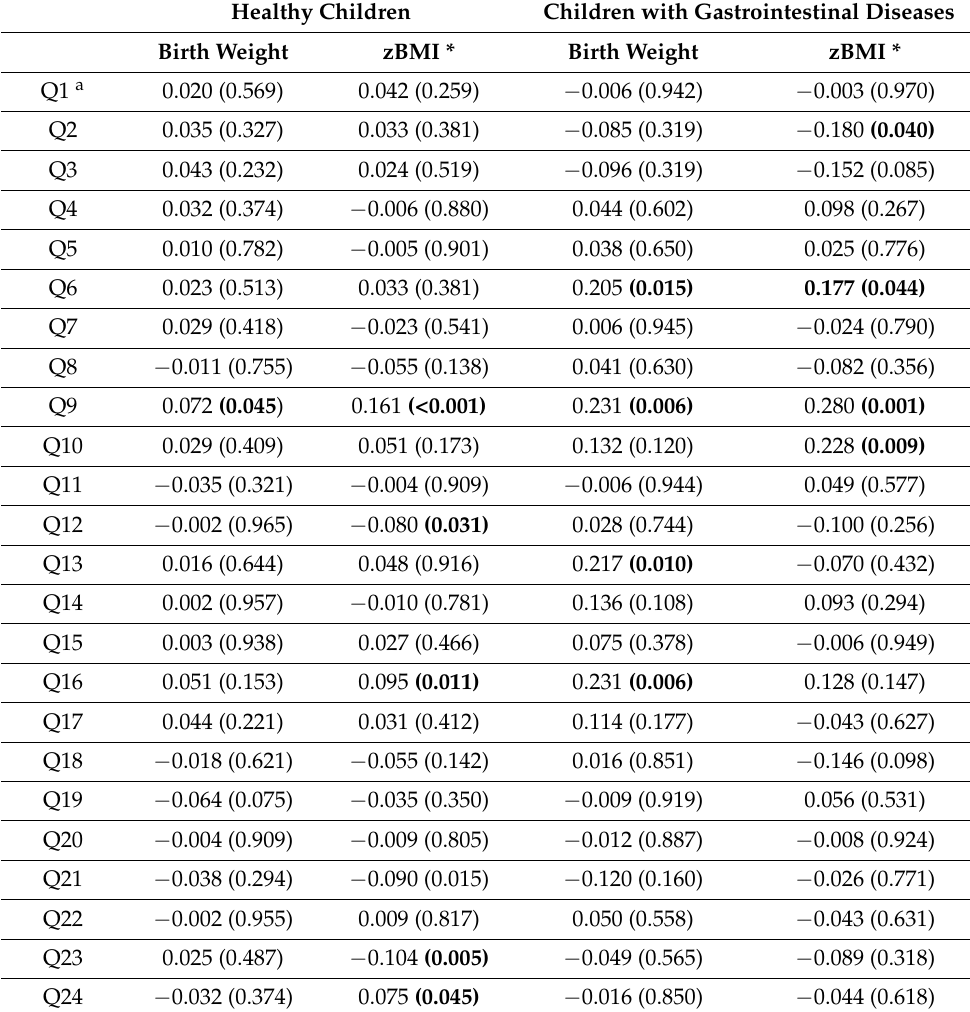
Table 4. Bivariate correlations between the mean score in Q1–Q24 and birth weight and zBMI *. Healthy